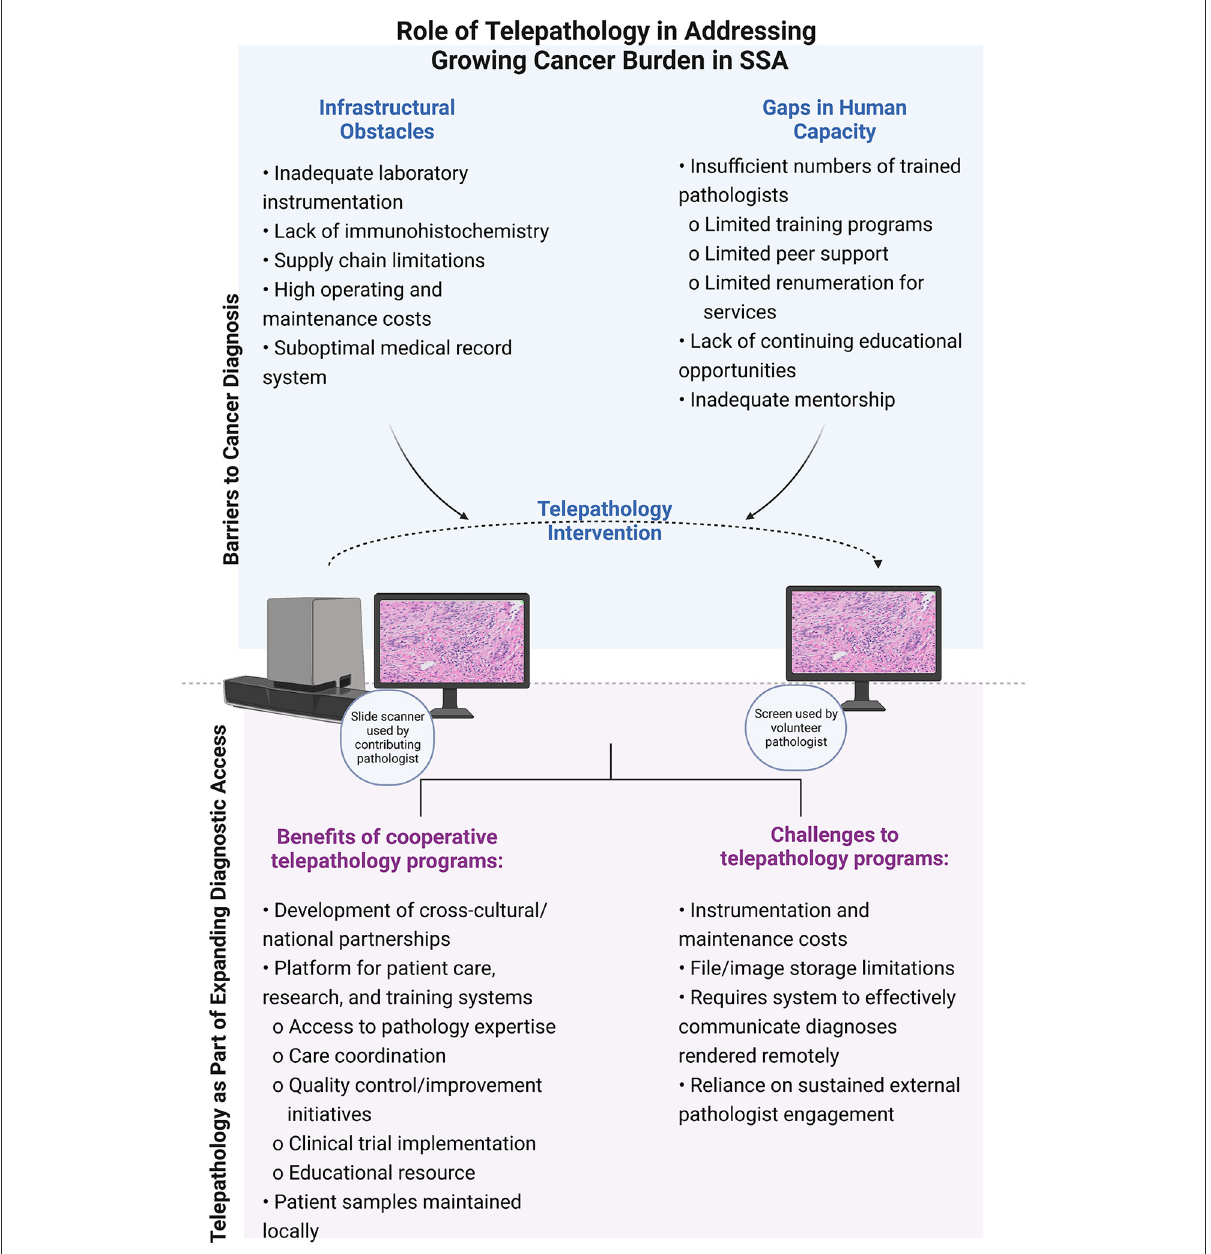
FIGURE1 The role of telepathology in addressing the growing cancer burden in sub-Saharan